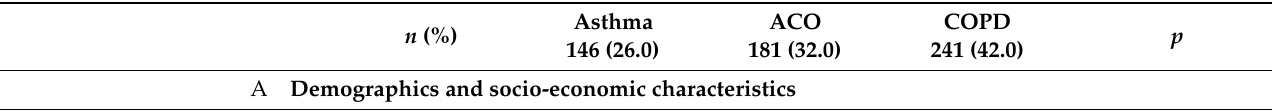
Table 1. Characteristics of asthma, ACO and COPD (N=568) [n(%)] .